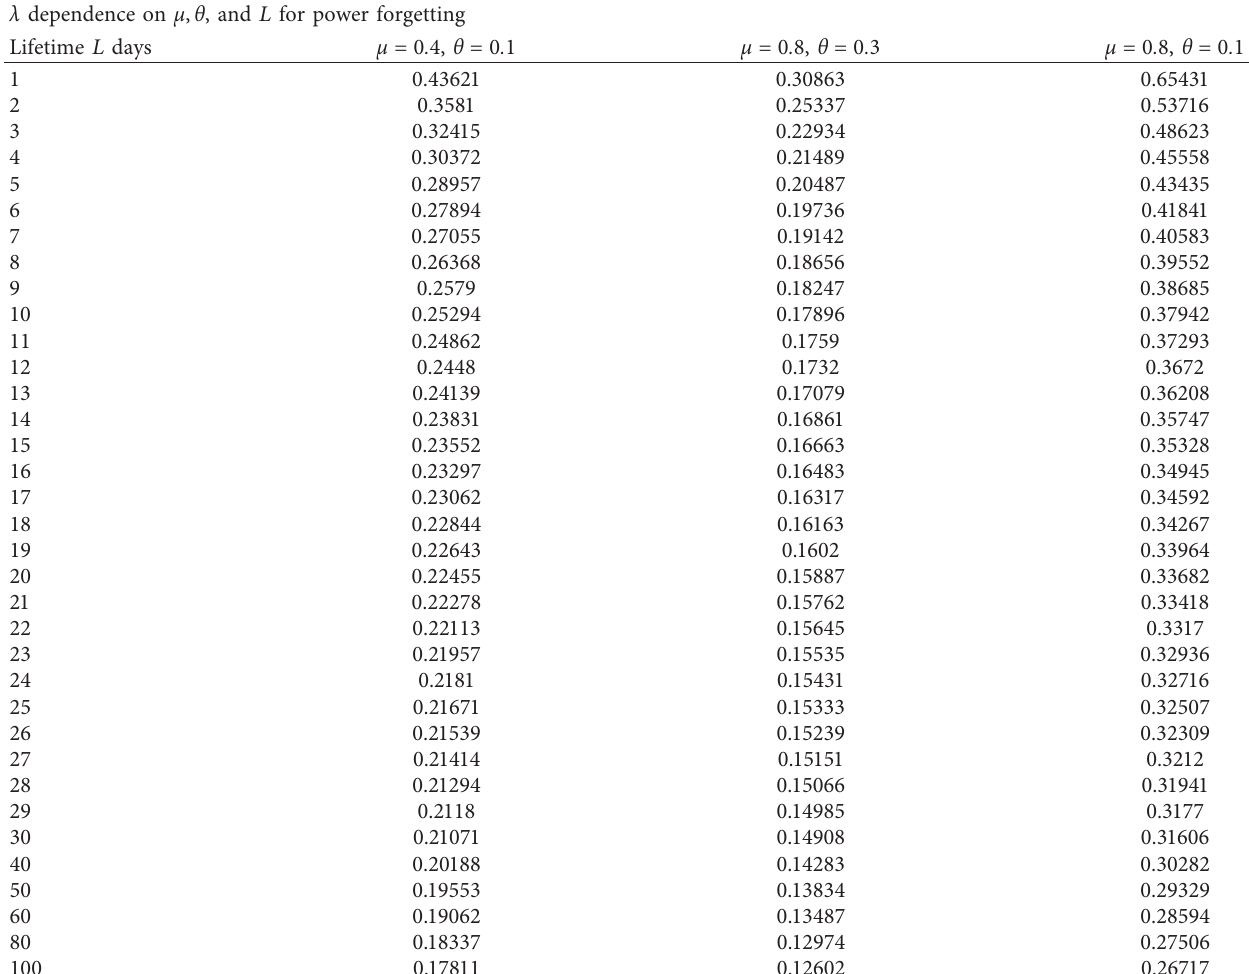
Table 2: Setting of parameters for power forgetting function in computational